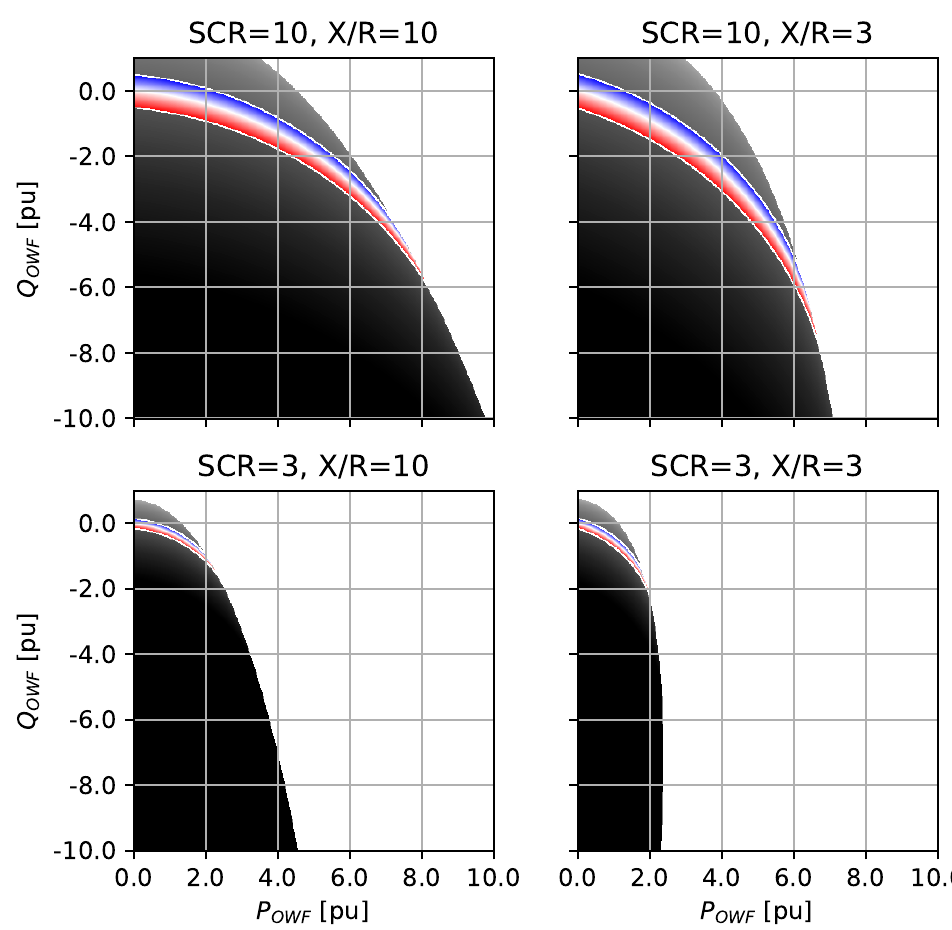
Figure 6. Compliant and feasible solution spaces ( C and F ) of a transmission line seen in PQV space for SCR , X / R ∈ { 3,10 } . The colors distinguish the X / R ratio; orange is the highest and blue the lowest. For each X / R ratio plotted, there is a dotted, dashed, and solid line. The solidity of the line indicates the corresponding relative grid strength. The plot is a 2D version of Figure